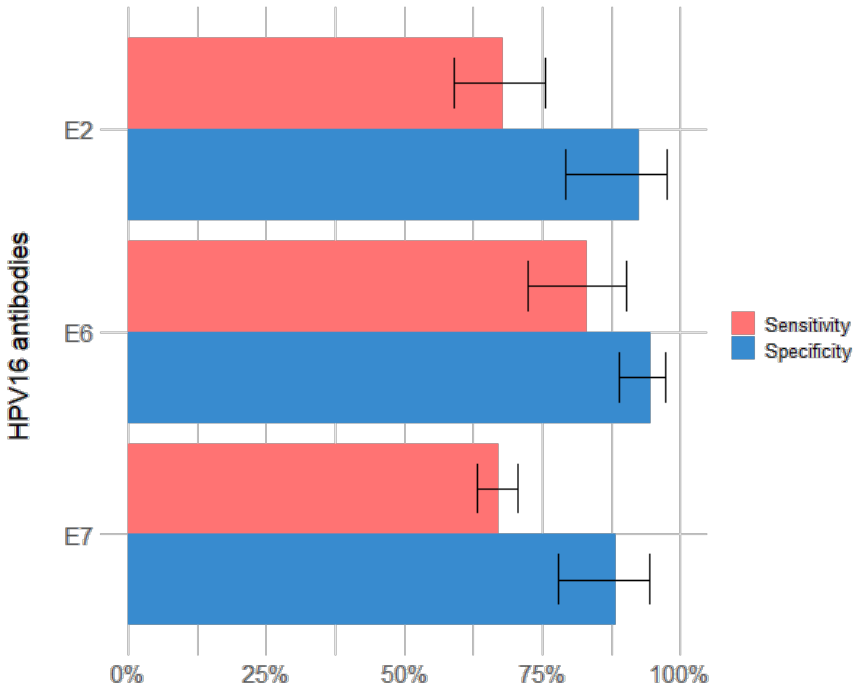
Figure 2. Bar plot of summary estimates of sensitivity (red) and specificity (blue) for HPV16 early protein serology (E2, E6 and E7) in comparison with molecular HPV tumor status. Whiskers represent 95% confidence intervals. Summary estimates were calculated by meta-analyses using random effects models.